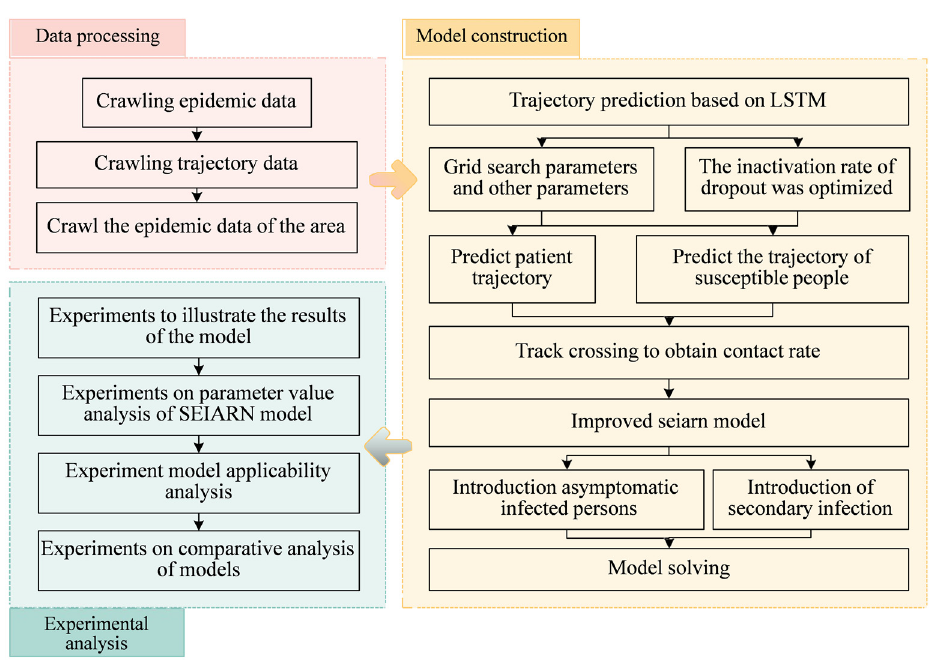
Figure 4. Algorithm flowchart.